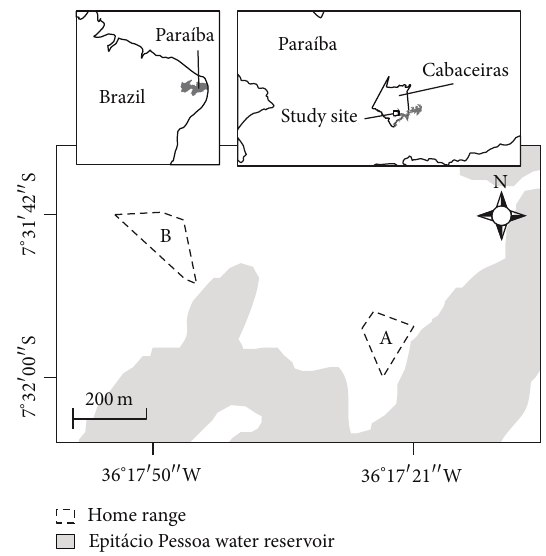
Figure 1: Study site at the Fazenda Marimbondo and home ranges of the wild Callithrix jacchus study groups (A and B) in the semiarid environment of